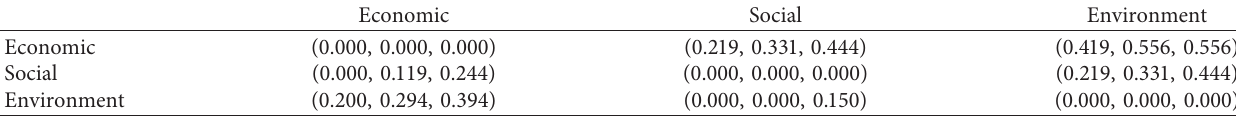
Table 17: Normalized matrix of sustainability dimensions in Z-number condition.